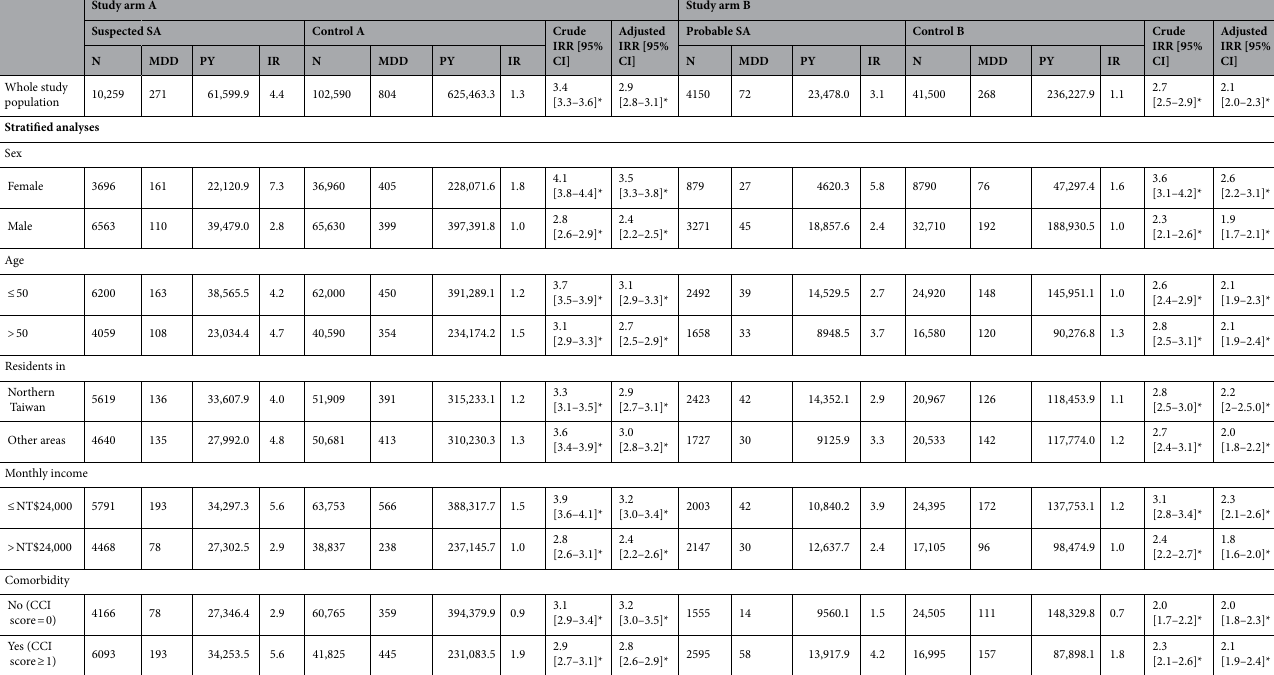
To confirm our findings, we selected the suspected SA patients and probable SA patients who had SA diagno- sis in at least three ambulatory claims or one inpatient claim (namely “highly suspected SA patients” and “highly probable SA patients”, respectively) and their corresponding control subjects (namely “control C subjects” and “control D subjects”, respectively) for another sets of analyses (study arms C and D) (Fig. 1, Supplementary Table S1 online). The study arms C and D showed consistent results as the findings in the study arms A and B (Supplementary Figs. S1, S2 and Table S2 online). The sensitivity analyses, taking only ICD-9-CM code of 296.2 (major depressive disorder, single episode) for the outcome (incident MDD), showed similar findings as those in the previous analyses (Supplementary Figs. S3–S6 and Tables S3–S4 online).